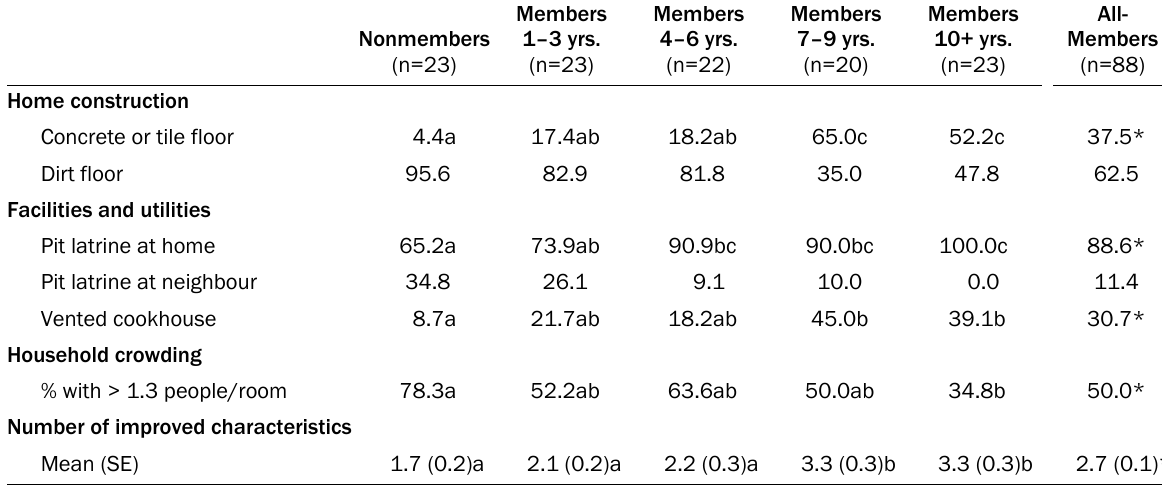
Table 2. Household Environment (% of households) and Number of